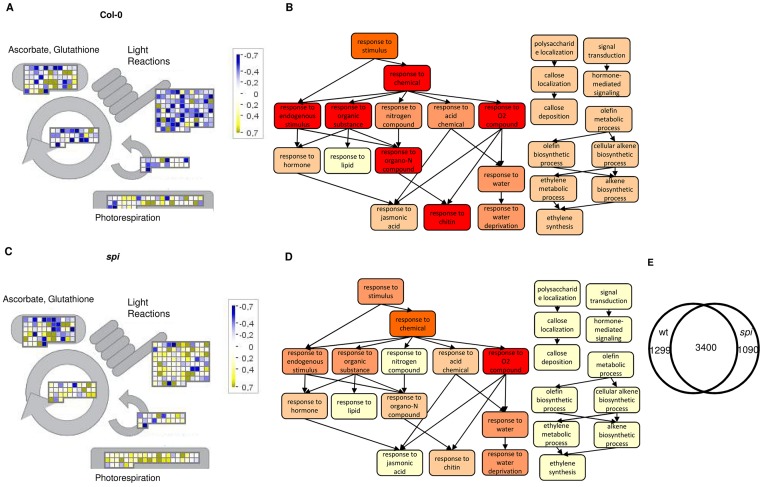
Transcriptome-wide analysis.(A) Mapman visualization of log2-fold changes in Col-0 upon salt treatment and (B) the corresponding 25 most strongly enriched GO terms. Darker colors in GO term categories represent higher q-values (BH-corrected). (C) Mapman visualization of log2-fold changes in spi upon salt stress induction and (D) the corresponding 25 most strongly enriched GO terms in spi. For color codes see 6C. (E) Venn diagram comparing the salt stress-dependent up-regulation of transcripts in Col-0 (wt) and spi (see also S8 Table).